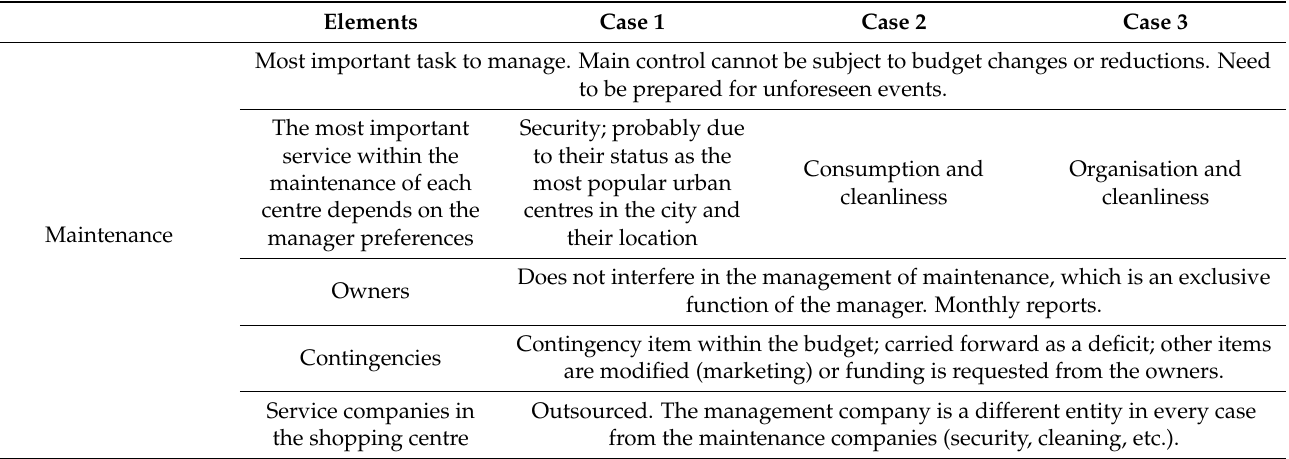
Table 5. Centre maintenance management 1